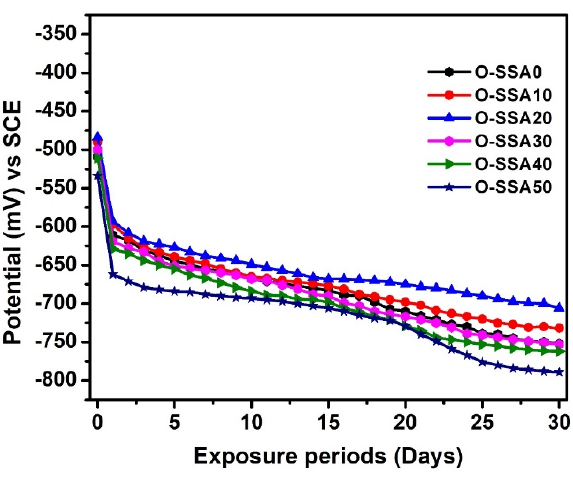
Figure 6. Chrono–potential curves for steel rebars in various cement extracts for an exposure period of 30 days.